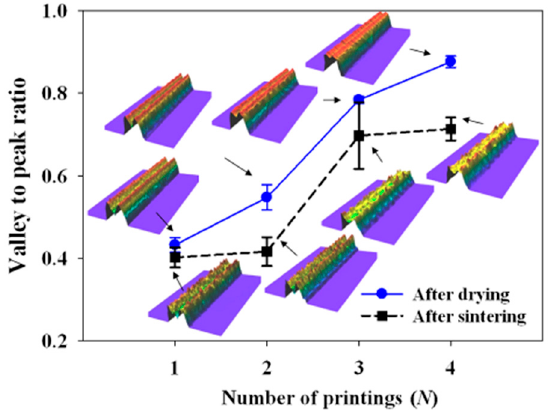
Figure 14. Ratio of the valley to peak in the morphology of inkjet-printed lines after drying and sintering on S 50 substrate for different numbers of printings at 125 °C substrate temperature.